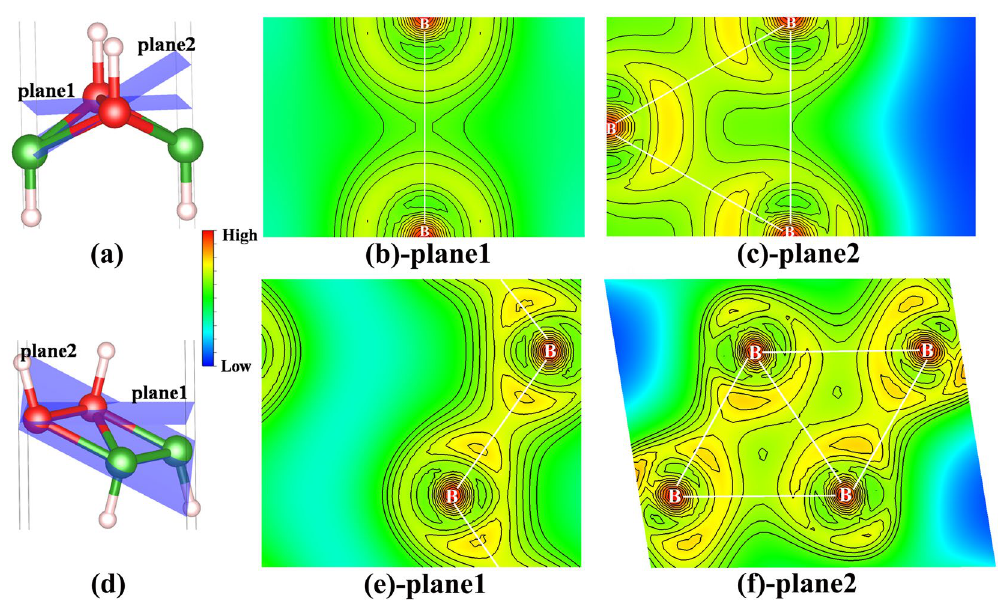
Figure 9. 2D charge density contour of two typical planes in C- and W-borophane. Plane1 is perpendicular to z coordinate axis and contains a B-B bond. Three nearest neighboring B atoms that constitute a triangle determine plane2. The red area represents the electron is dense in the area, however, the blue area represents the electron is sparse in the area.